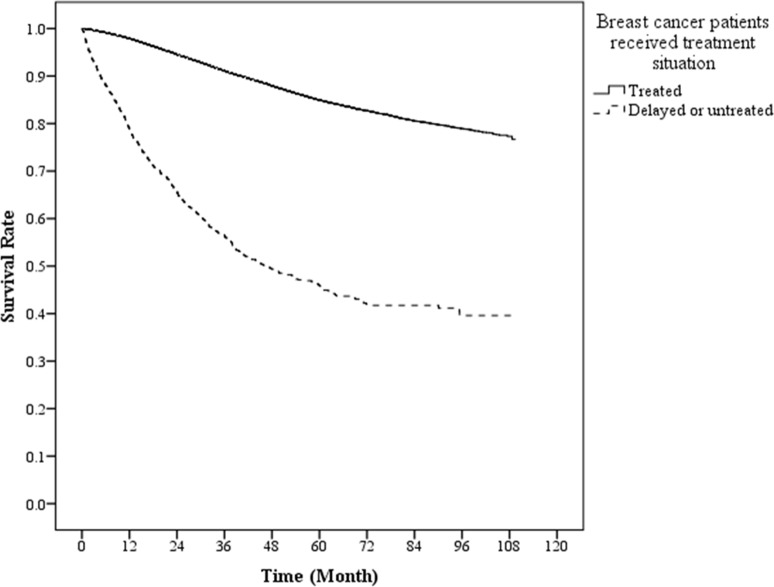
Overall survival curves between treated and delayed/untreated patients of breast cancer.